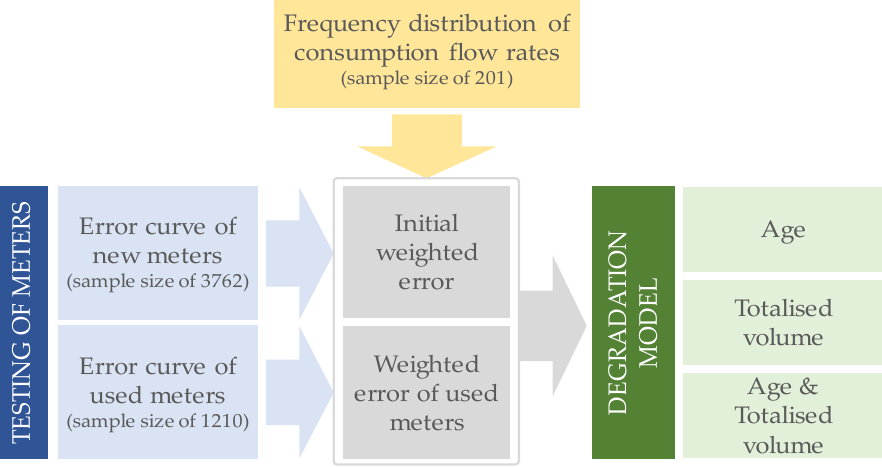
Figure 1. The diagram of the methodology used.